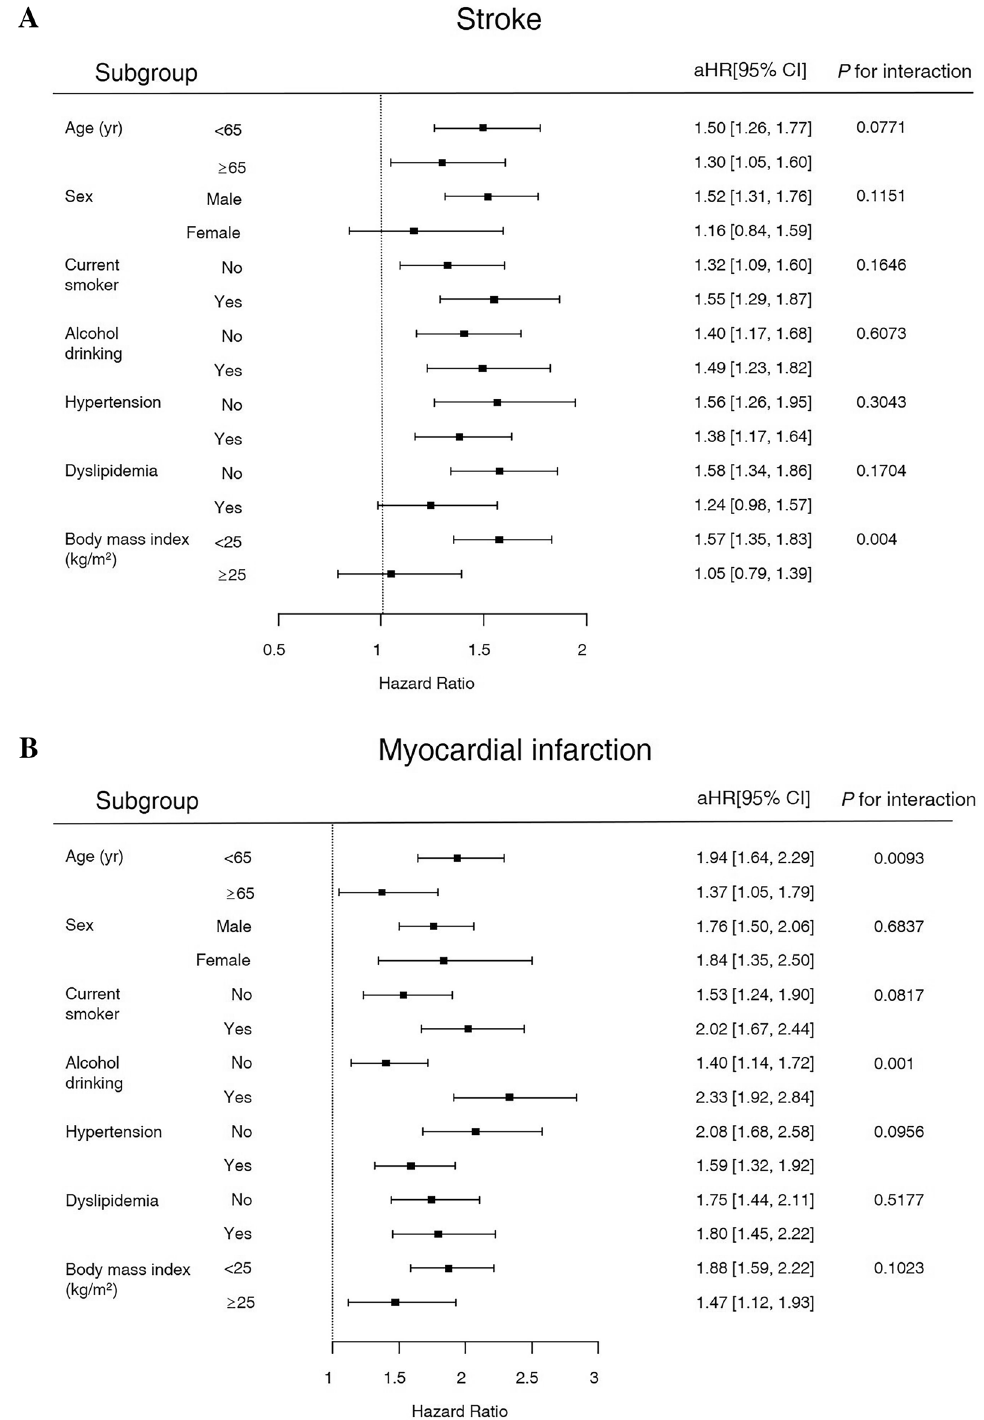
Figure 2. Forest plots for the risk of cardiovascular disease and mortality in subgroup analyses. ( A ) HR of stroke, ( B ) HR of myocardial infarction, and ( C ) HR of